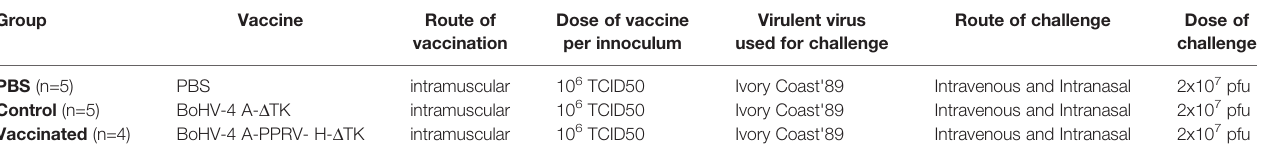
TABLE 1 | Experimental design showing different groups of animals. Group Vaccine Route of